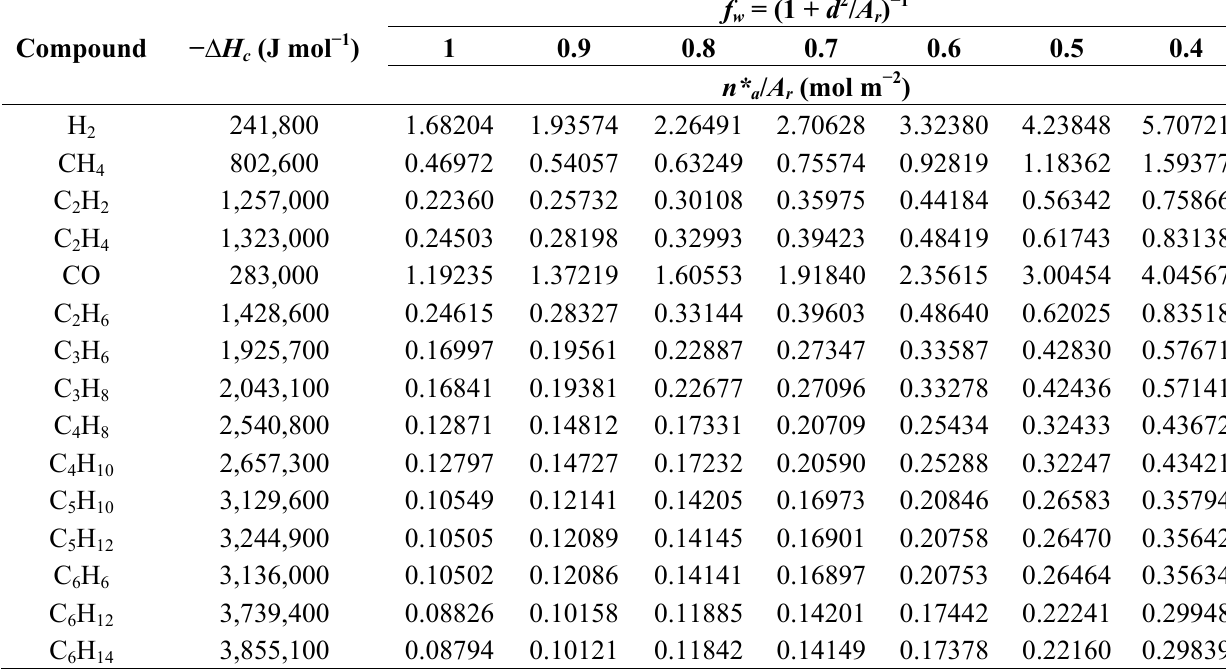
Table 3. Maximum allowed build-up per unit surface calculated for different positively/neutral buoyant gases and dense gases, considering radiating heat constraint. Compound